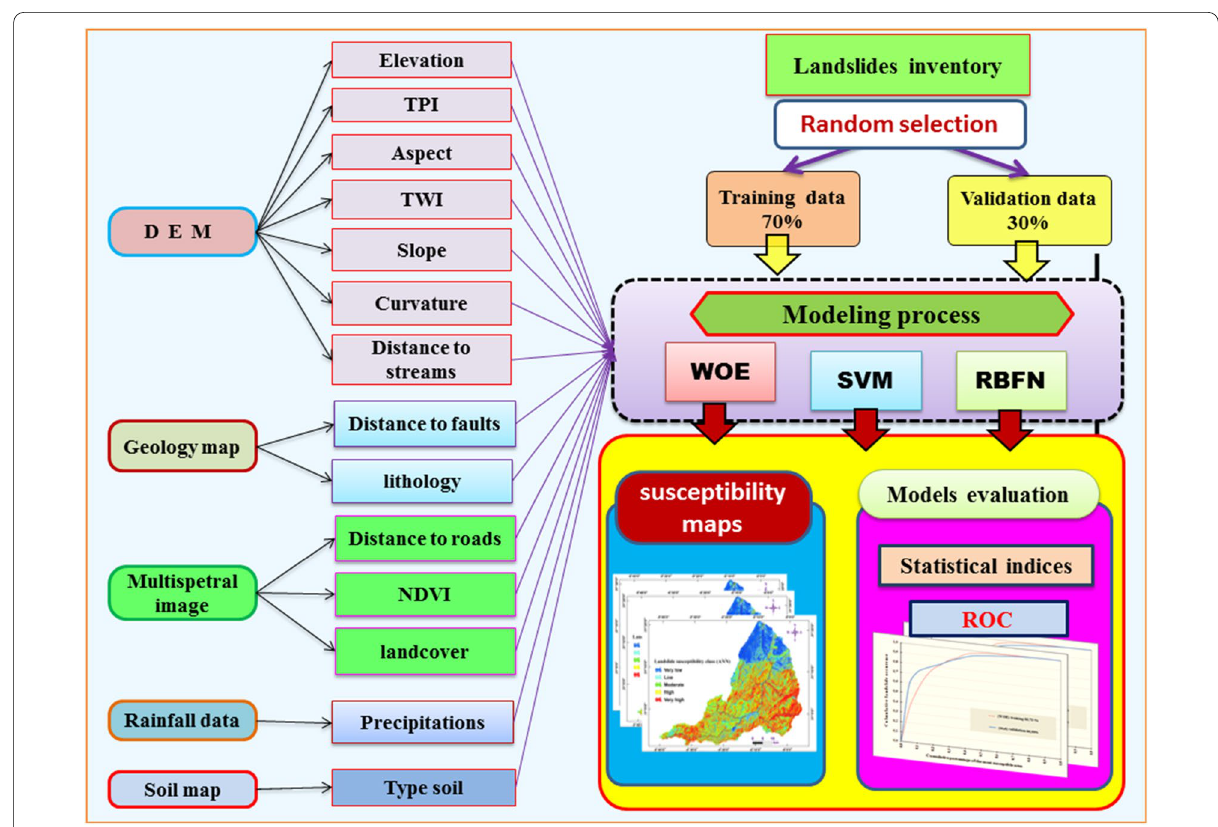
Fig. 2 Flowchart of the developed